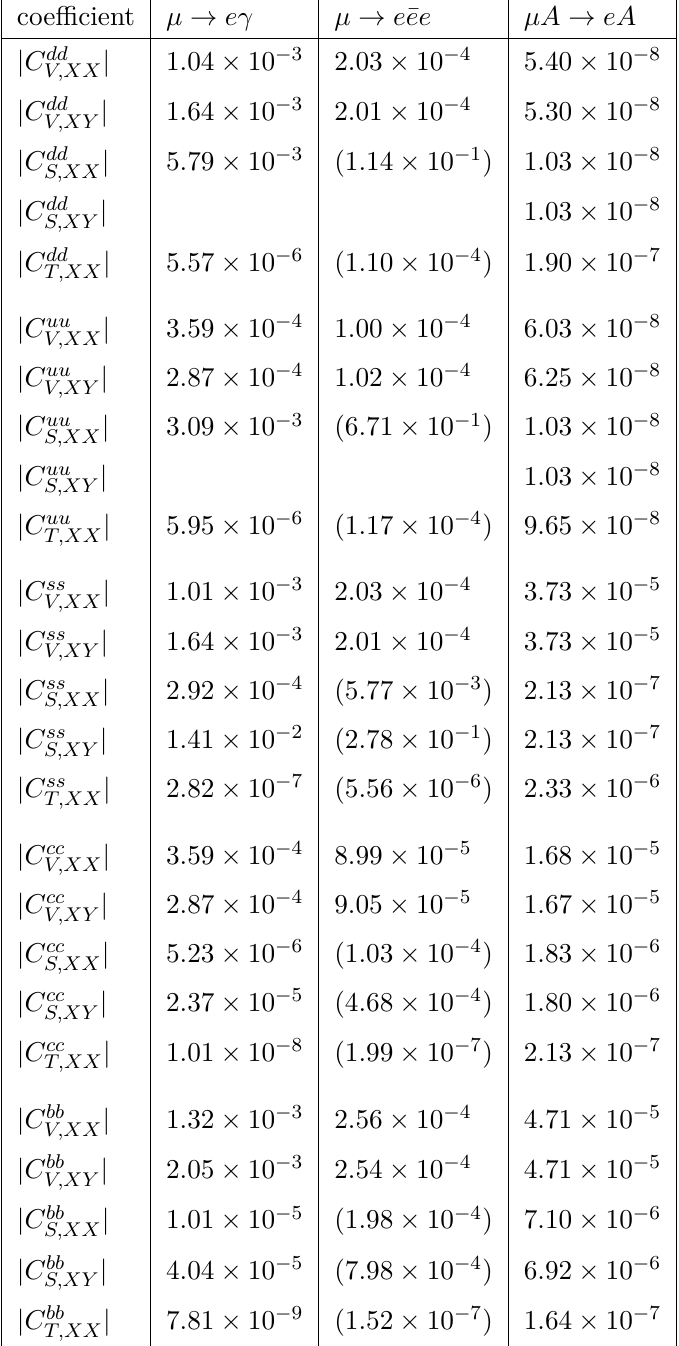
Table 4 . Current sensitivities of the processes in the first row to the coefficients, evaluated at m W , of QCD × QED-invariant 2-lepton-2quark operators defined in section 2.1. X, Y ∈ { L, R } , X 6 = Y